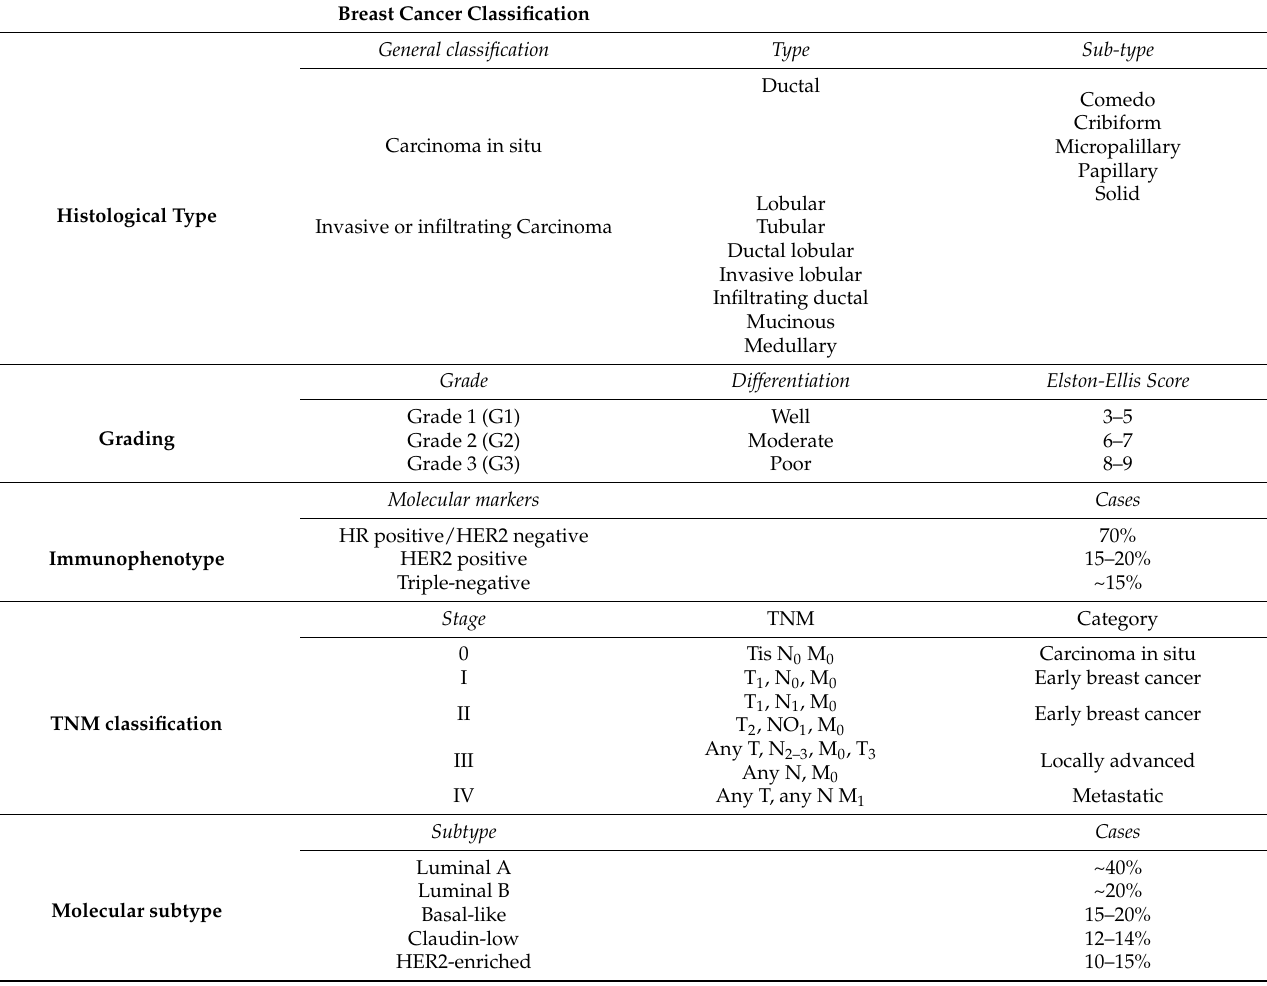
Table 1. The main types of classification of breast